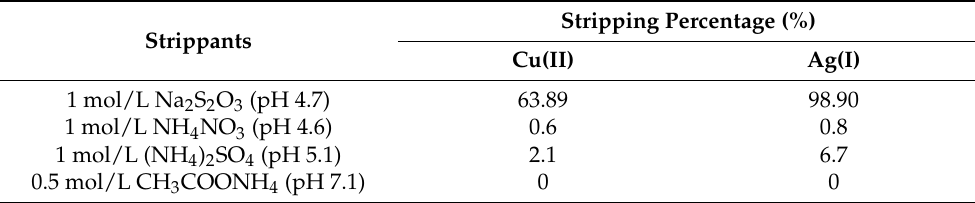
Table 3. Stripping of Cu(II) and Ag(I) from the loaded LIX63 with various strippants.